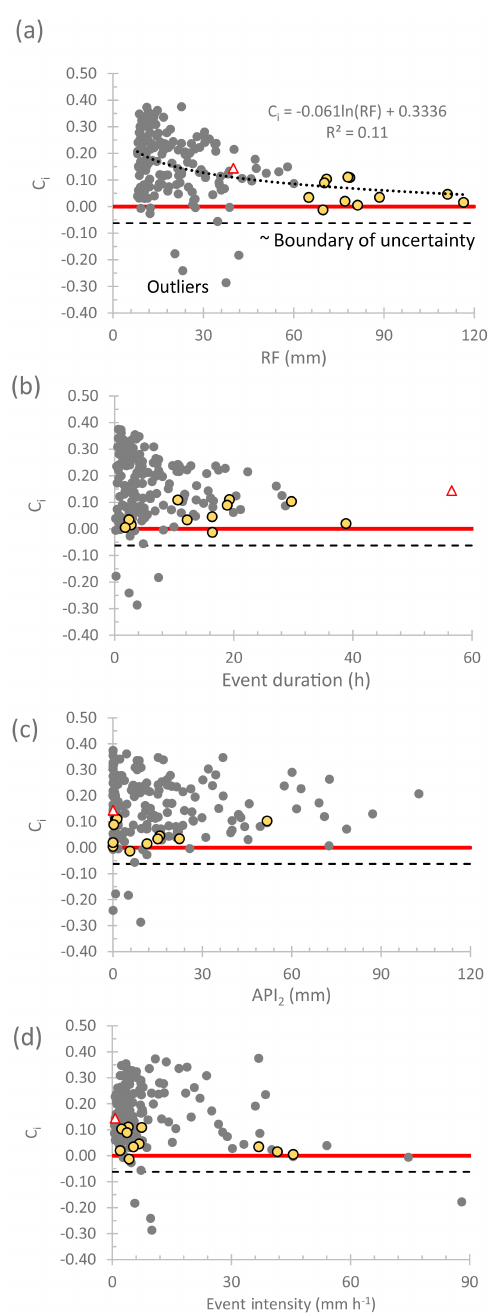
Figure 3. (a) Canopy interception ratio ( C i ) versus total event rainfall for all monitored events. The nonlinear regression curve describes the tendency for C i to approach 0 as total rainfall in- creases. (b) C i plotted with respect to event duration (h). (c) C i plotted against 2-day antecedent precipitation (API 2 ) . (d) C i plot- ted with respect to mean event intensity (mmh − 1 ) . The open circles and the triangle in all panels refer to the 11 large and 1 long storm investigated in detail (Table 2). The four events plotted below the dashed line are considered